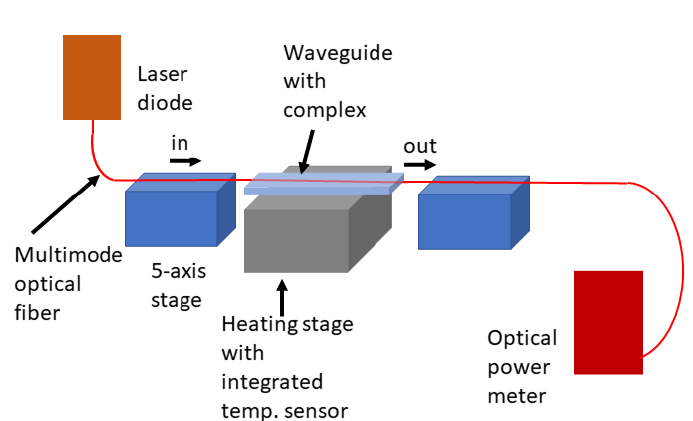
Figure 5. Optical setup used for measurement of the change in temperature versus temperature applied to the sample.